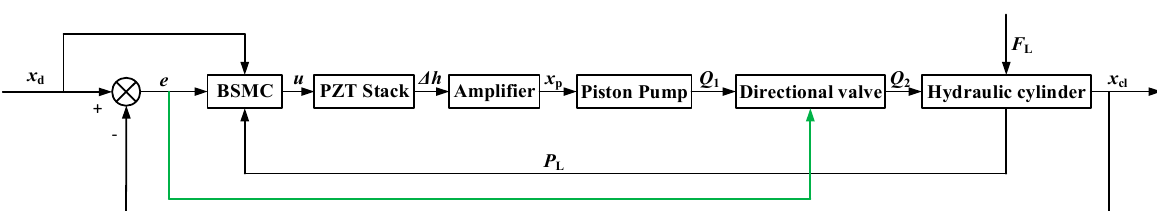
Figure 2. Block diagram of the backstepping sliding-mode control system.